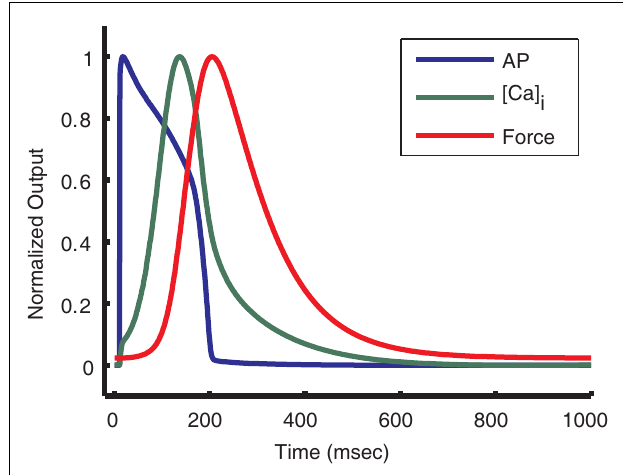
FIGURE 14 |Action potential shape causes delayed Ca 2 + transient and force. Normalized output from the guinea pig model is used to compare the kinetics of the AP, [Ca] i transient, and force transient. As seen above, the [Ca] i transient peaks near the end of the AP plateau.The force transient peak is further delayed and occurs after almost full repolarization of the